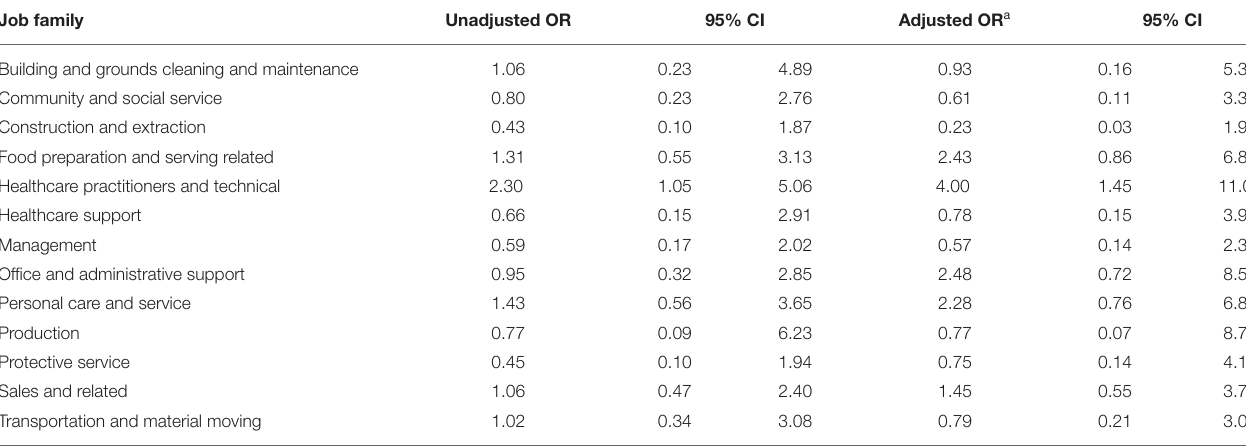
TABLE 3 | Associations between job families and the risk of testing positive for SARS-CoV-2 by RT-PCR assay among the study population. Job family